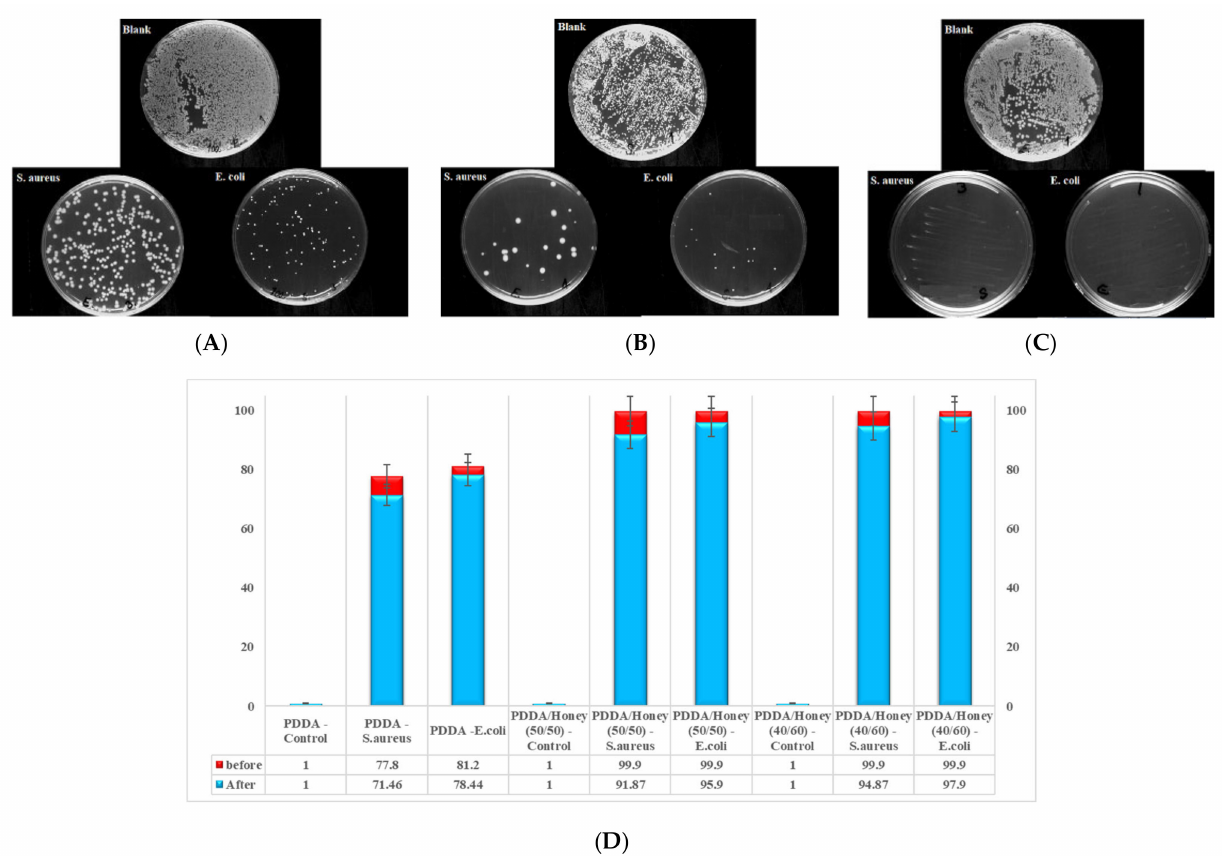
Figure 5. The antibacterial activity of fabricated materials against E. coli and S. aureus . ( A ) PDDA, ( B ) PDDA/honey (50/50) nanofiber composite, ( C ) PDDA/honey (40/60) nanofiber composite, and ( D ) before dilution and after